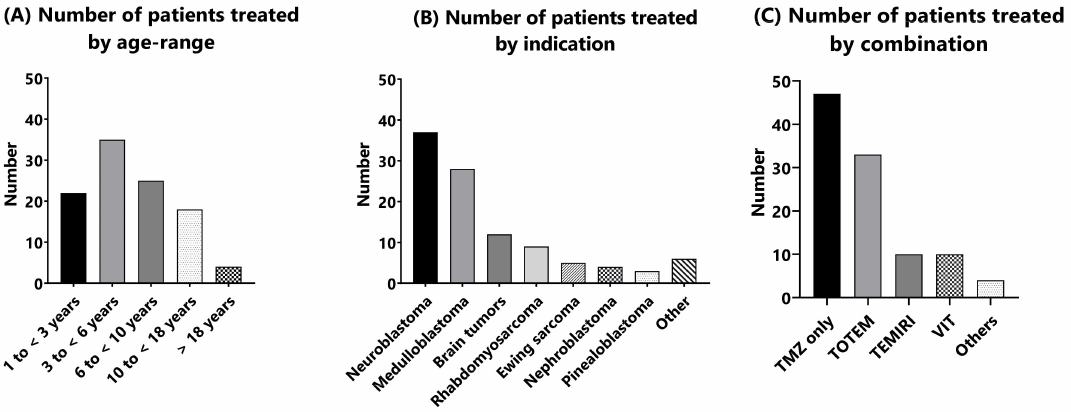
Figure 5. Number of patients treated with TMZ suspension by age range ( A ), per indication ( B ) and per combination ( C ) (TMZ only: children treated with temozolomide suspension in monother- apy; TOTEM: association of temozolomide and topotecan; TEMIRI: association of temozolomide and irinotecan; VIT association of vincristine, irinotecan and temozolomide; Others: associations corresponding to temozolomide associated with other